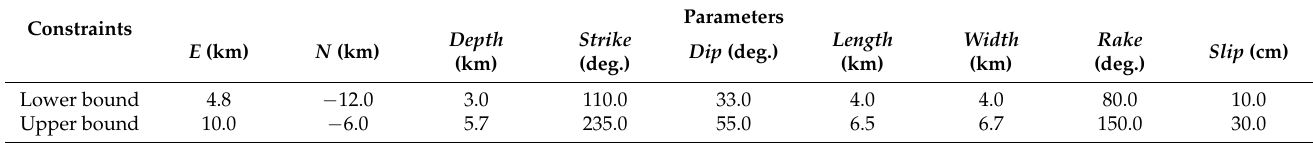
Table 7. Bound constraints of source parameters.